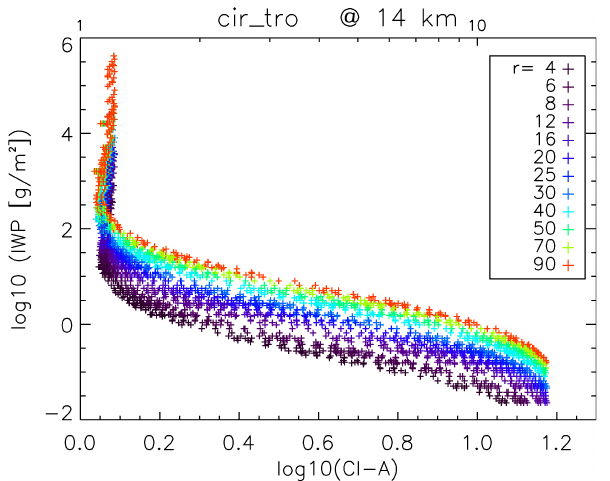
Fig. 6. Correlation diagram between log 10 ( CI A ) and log 10 (ADP) with ADP in m 2 cm − 2 for tropical CSDB spectra at 14km tangent height (dots). Roots mean square error bars with respect to a fitted 4th order polynomial are